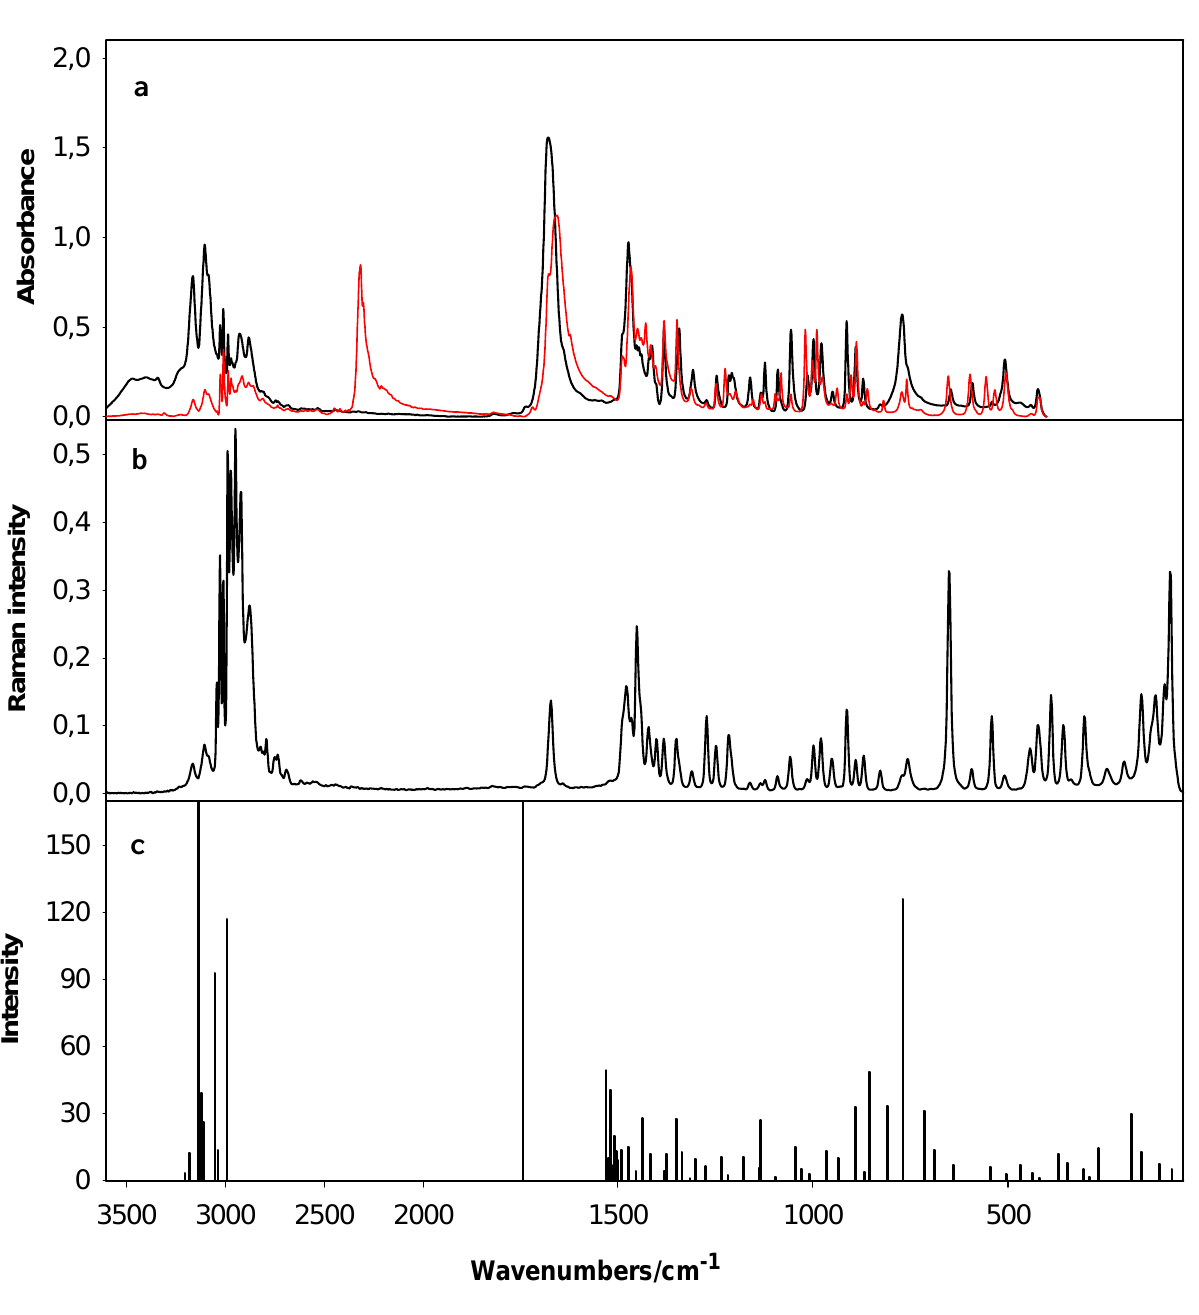
Figure 2 . Spectra of 1,1-dimethyl-3-oxo-1,4-diazepan-1-ium chloride ( 1 ): (a) FTIR (suspension in Nujol and Fluorolube, red line – deuterated analogue), (b) Raman and (c) calculated